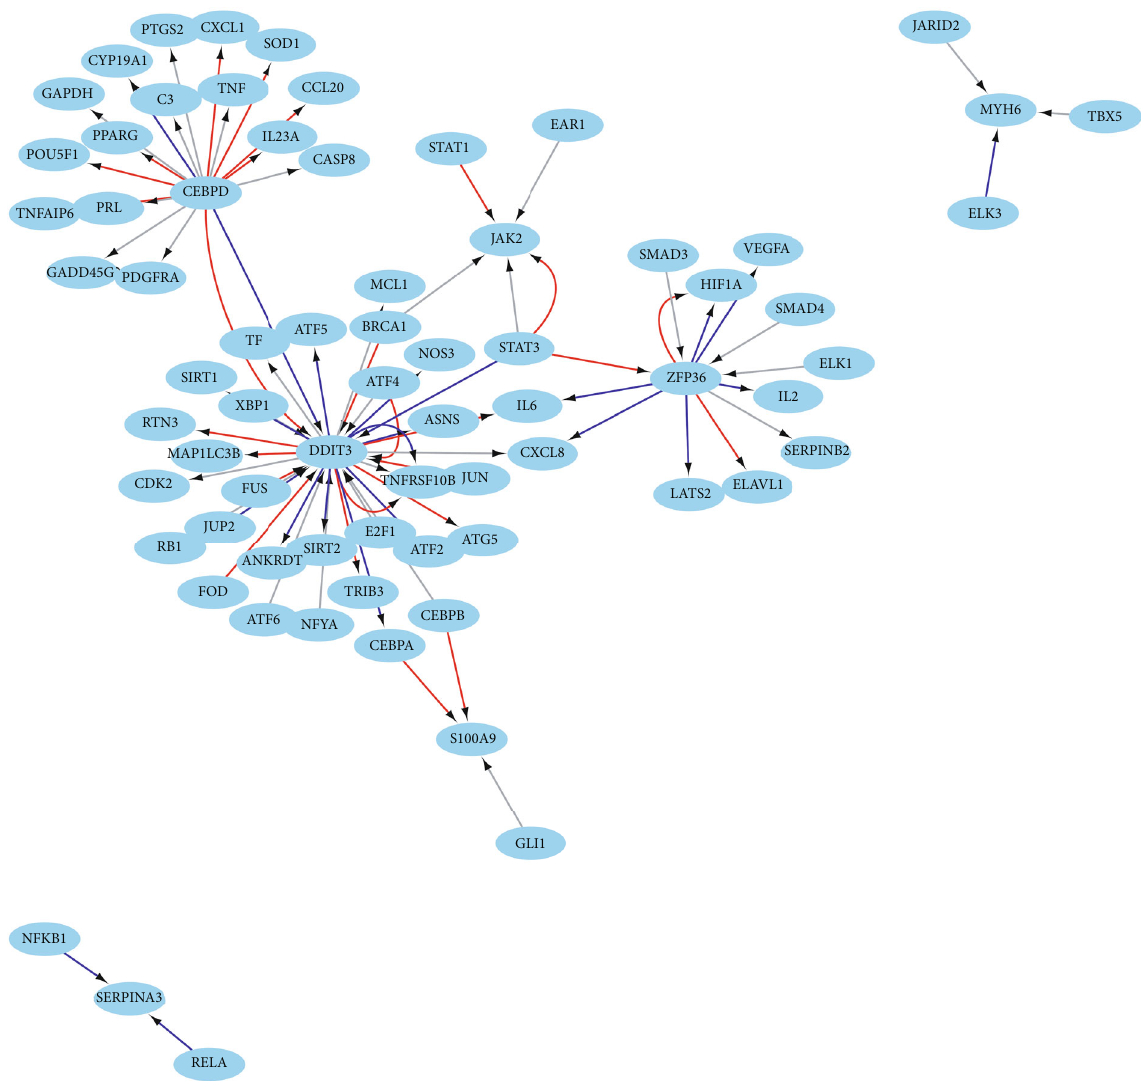
Figure 4: Transcriptional factor regulatory network diagram. The arrows pointed from TF to the target gene. The color of the line was red for activation, blue for repression, and gray for